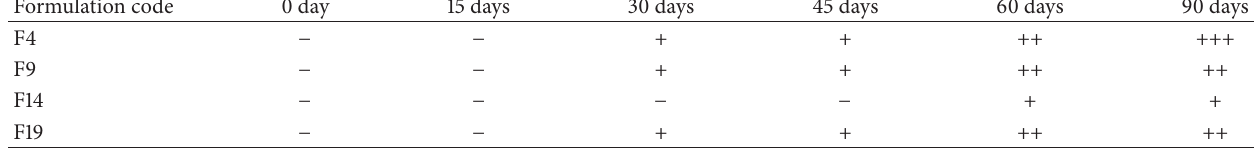
Table 2: Degree of sedimentation of TDF loaded niosomes after being stored at 4 ∘ C for 3 months.